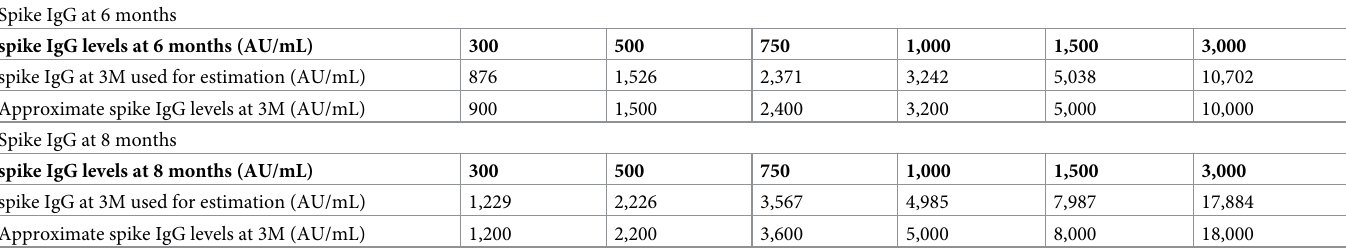
spike IgG at 3M used for estimation (AU/mL) Approximate spike IgG levels at 3M (AU/mL)